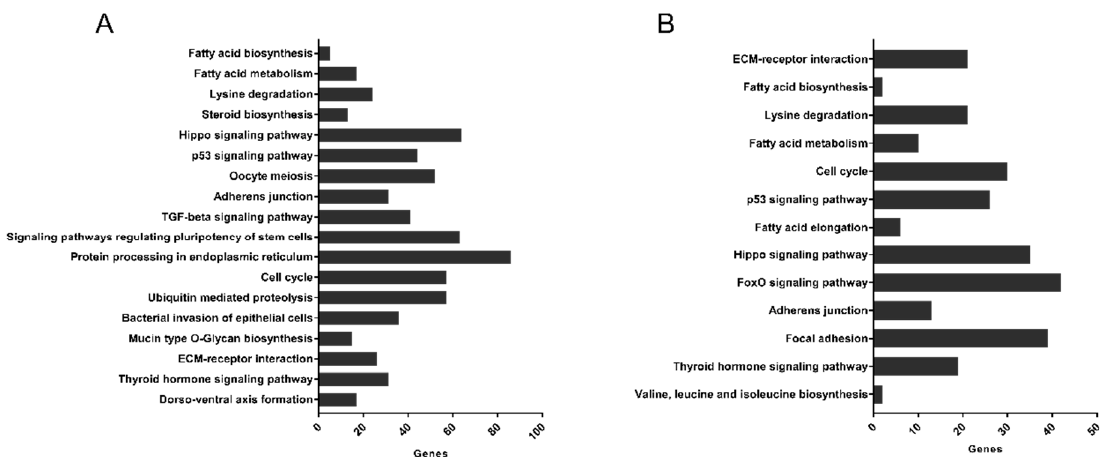
Figure 7. The KEGG pathways strongly associated with the miRNAs differentially expressed following 20 µ g mL − 1 HDL (24 h) treatment were identified through bioinformatics analyses using miRPath v.3.0. Ten downregulated miRNAs and 4 upregulated miRNAs were used for analysis. Pathways associated with downregulated or upregulated miRNAs are presented in ( A , B ), respectively. Pathways are ranked, in order of the most closely associated